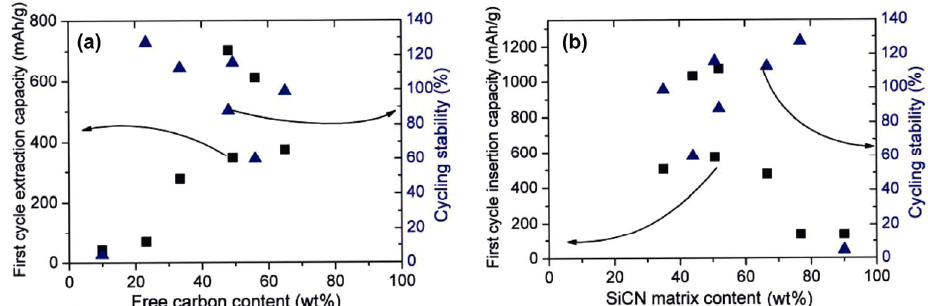
Fig. 23 Dependence of the lithiation/delithiation capacity of SiCN-derived materials on the amount of free carbon (a) and on the amount of SiCN matrix (b). Reproduced with permission from Ref. [435], © the authors